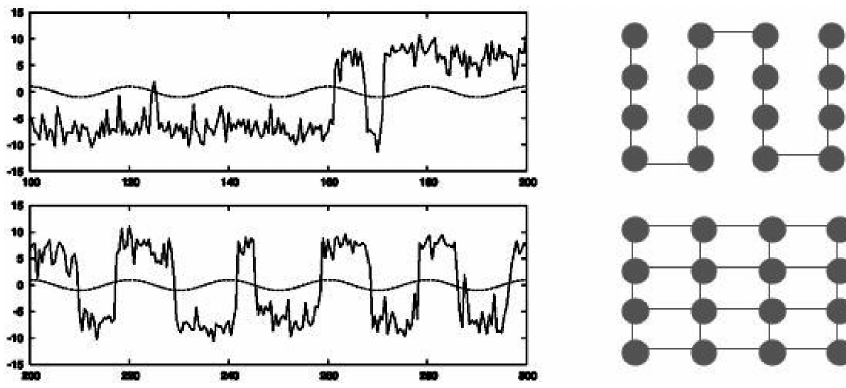
Fig. 8. Numerical simulation of Eq. (15) with the same parameters m , g , σ and two different topology (shown in the figure): one dimensional lattice (upper panel), two dimensional lattice (lower panel). The amplitude and the period of the periodic forcing is the same for both cases. While the two dimensional lattice shows stochastic resonance, the same is not true for the one dimensional case.